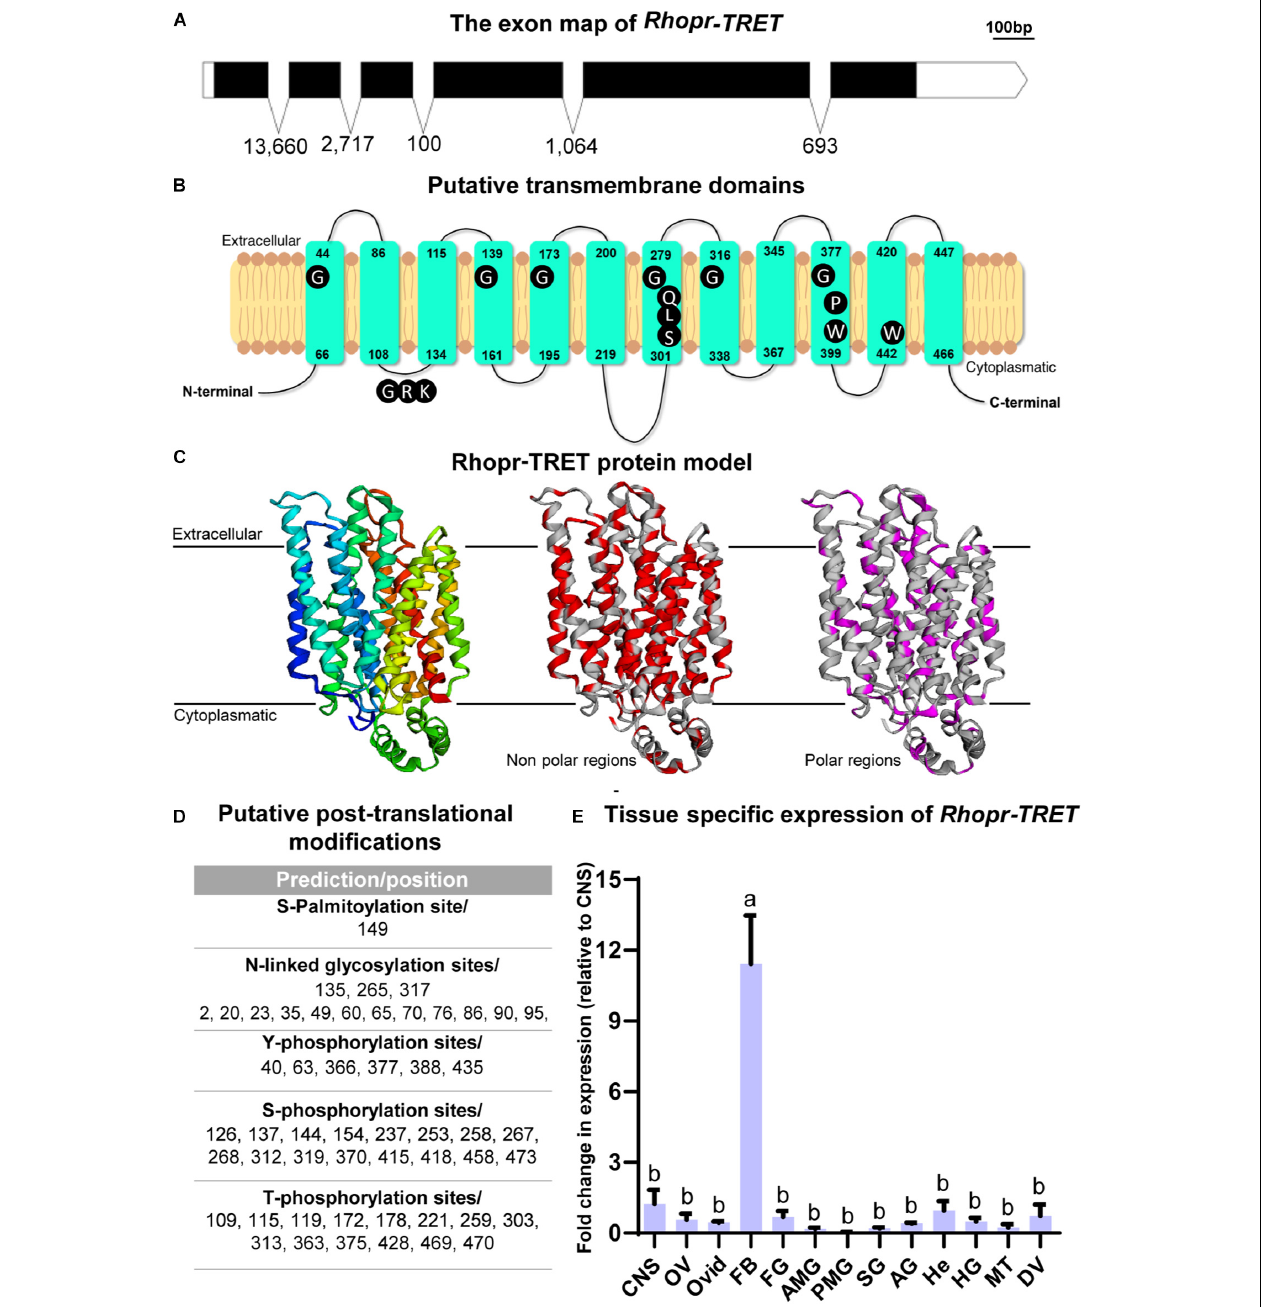
FIGURE 2 | Rhopr-TRET characterization and modeling. (A) Exon map of Rhopr-TRET of the open reading frame (ORF) and exons/introns. The ORF of Rhopr-TRET is denoted by the solid black box spanning the exons. The length of each box is representative of the nucleotide number (bar = 100 bp) and the numbers below represent the intron length as base pairs (bp). (B) Schematic diagram of Rhopr-TRET . The 12 transmembrane domains within the cell membrane and the position of the amino acids indicating the start and end of each transmembrane regions are shown. Conserved motifs among Rhopr-TRET sequences are highlighted in dark in their typical positions. (C) Molecular model of Rhopr-TRET. Cartoon representation of Rhopr-TRET illustrating the folds of the transporter; the putative non-polar and polar regions are also displayed. (D) Putative post-translational modifications, including N -glycosylation, phosphorylation and palmitoylation sites. (E) Distribution of Rhopr-TRET transcript in unfed adult female R. prolixus ; central nervous system (CNS), ovaries (OV), oviducts (Ovid), fat body (FB), foregut (FG), anterior midgut (AMG), posterior midgut (PMG), salivary glands (SG), accessory glands (AG) (spermatheca and cement gland), hemocytes (He), hindgut (HG), Malpighian tubules (MT) and dorsal vessel (DV). The expression of transcripts in each tissue was quantified by RT-qPCR. The y- axis represents the fold change in expression relative to CNS (value ∼ 1). The results are shown as the mean ± SEM ( n = 3–4, where each n represents a pool of tissues from 3 insects). Statistically significant differences were determined by a one-way ANOVA and a Tukey’s test as the post hoc test. Different letters indicate significant difference at P < 0.05.